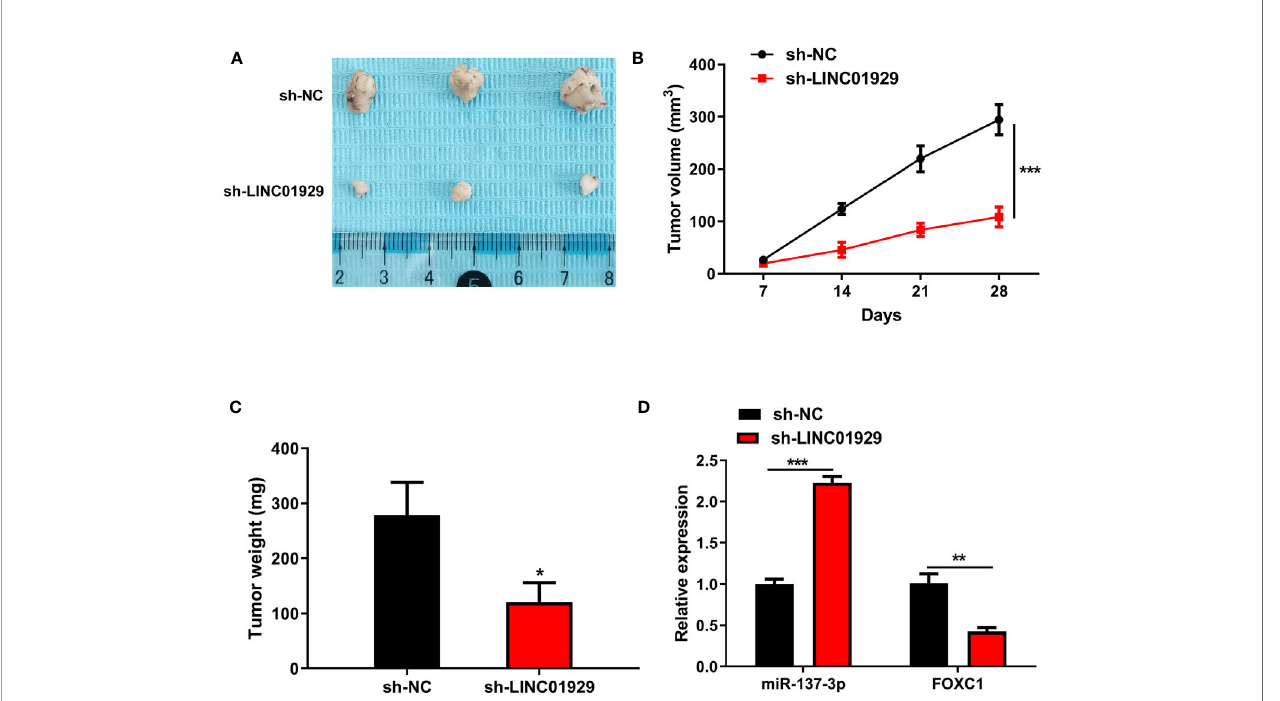
FIGURE 7 | Downregulation of LINC01929 inhibited tumor growth in vivo . (A) Tumor images at 28 days post-xenotransplantation from the sh-LINC01929 groups and sh-NC groups. (B) Quanti fi cation of tumor volume was undertaken every seven days after the xenotransplantation. (C) Tumor weight was monitored after the experiment. (D) qRT-PCR was employed to identify miR-137-3p expression and FOXC1 expression in xenograft tumors. *p < 0.05, **p < 0.01, ***p < 0.001.